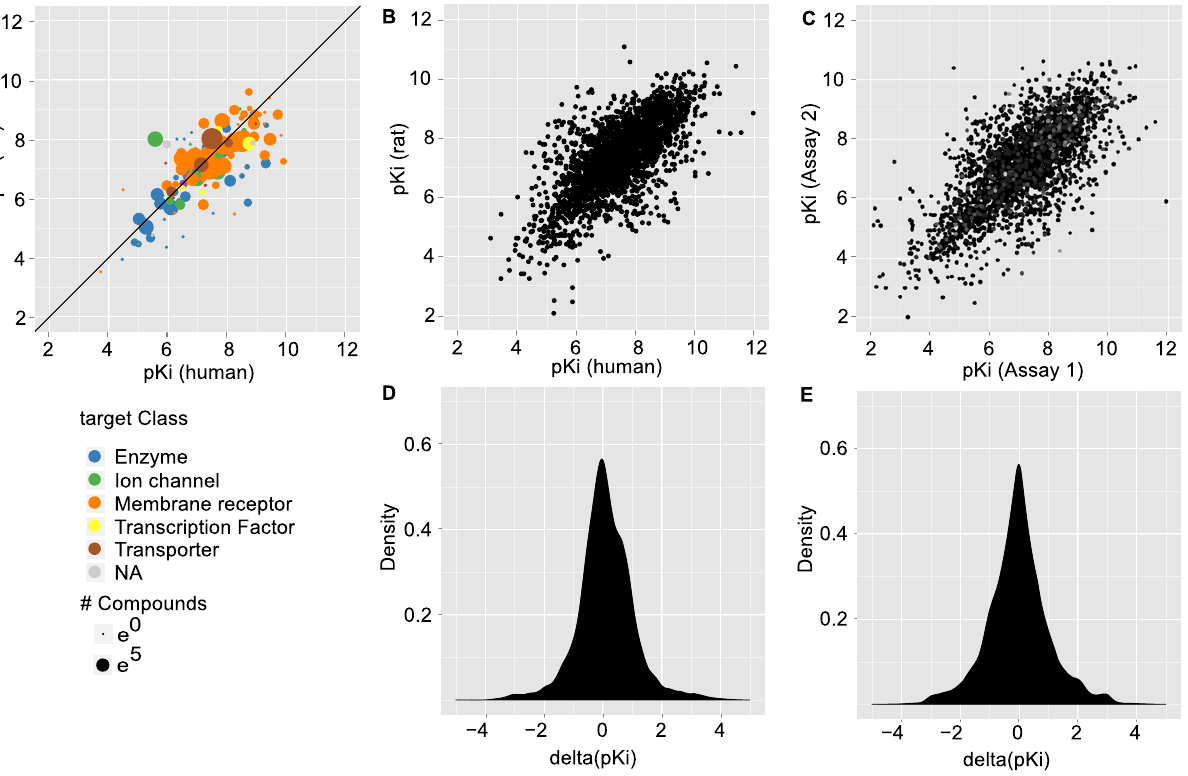
Figure 1. Differences in small molecule binding for human to rat orthologs. (a) Summary scatter plot. Positions along axes report the median binding affinity of all compounds against the human target (x-axis) and its ortholog in rat. Points are scaled according to the number of different compounds tested against a pair of orthologs. (b) Scatter plot of individual compound binding affinities for the human targets (x-axis) and their orthologs in rat (y-axis). (c) Scatter plot of the affinities observed when comparing results from different assays of the same compound and target (1500 human targets and 1500 rat targets). (d) Distribution of differences in binding affinity between the human target and its ortholog in rat. Positive values indicate higher affinity for the human target and vice versa. (e) Distribution of the differences observed when comparing binding affinities for the same compound and target in different assays.